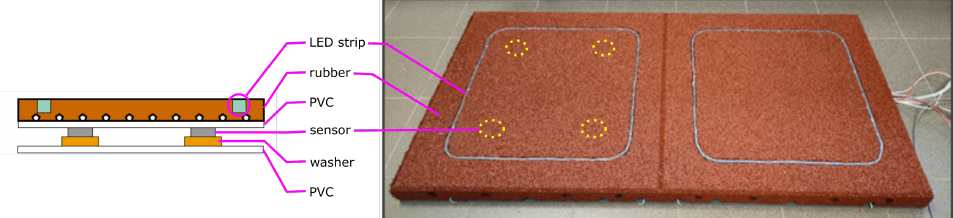
Figure 2. Cross-section of the smart tile ( left ) and an actual image of a two-tile mat ( right ). Four pressure sensors are embedded into each tile, possibly to allow for a spatial resolution finer than the tile pitch: the upper PVC layer is 3 mm thick, and it is flexible enough not to jeopardize such a spatial resolution, at the same time allowing for correctly spreading the force distribution above the sensors, regardless of the rough rubber